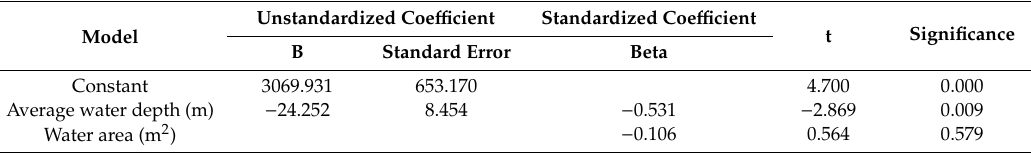
Table 7. The results of the binary regression analysis with the average water depth and water area as independent variables.